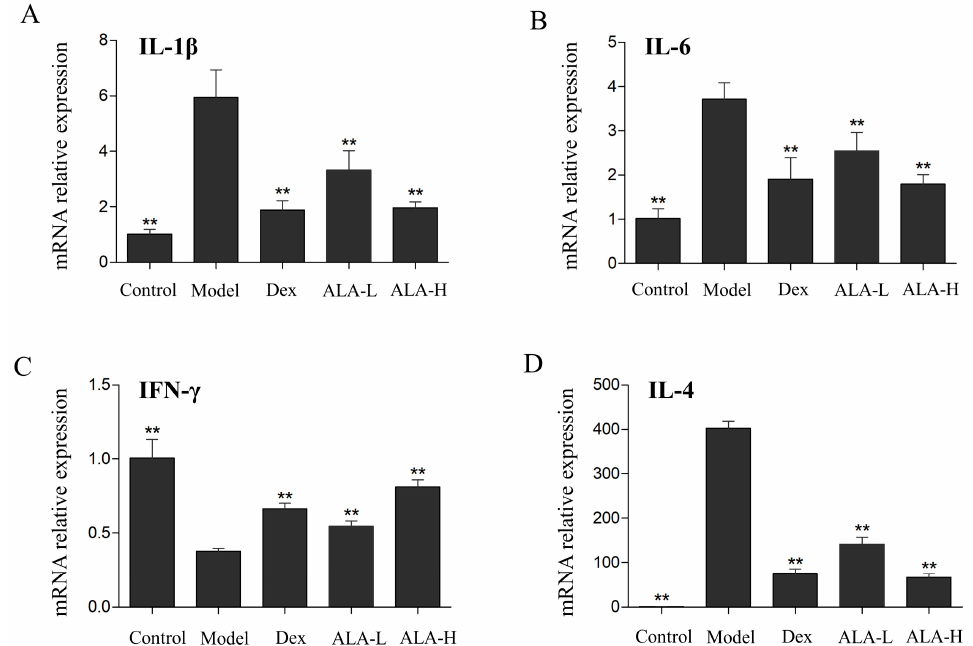
Figure 3. Effect of ALA on the mRNA expression levels of IL-6 ( A ), IL-1 β ( B ), IFN- γ ( C ), and IL-4 ( D ) in the nasal mucosa of AR mice. Between-group comparisons were performed using one-way ANOVA coupled with LSD t -test (equal variances assumed) or Tamhane’s T2 test (equal variances not assumed). Data are expressed as mean ± SD; n = 4; ** p < 0.01 versus AR model. Dex, dexamethasone; ALA-L, low dose of α -linolenic acid; ALA-H, high dose of α -linolenic acid.